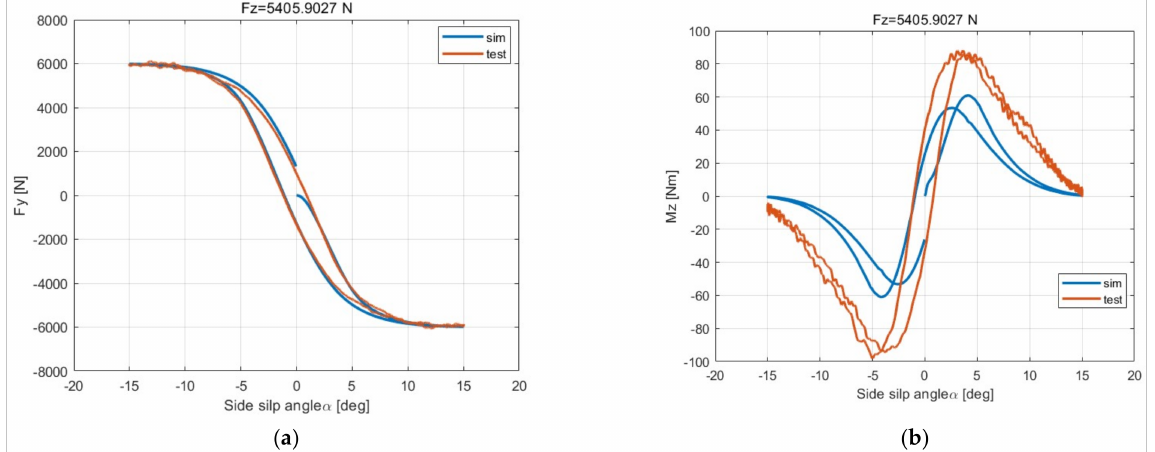
Figure 11. Pure side slip comparison between model and test at 0.05 Hz at V = 10 km/h. ( a ) Side force Fy; ( b ) Aligning moment